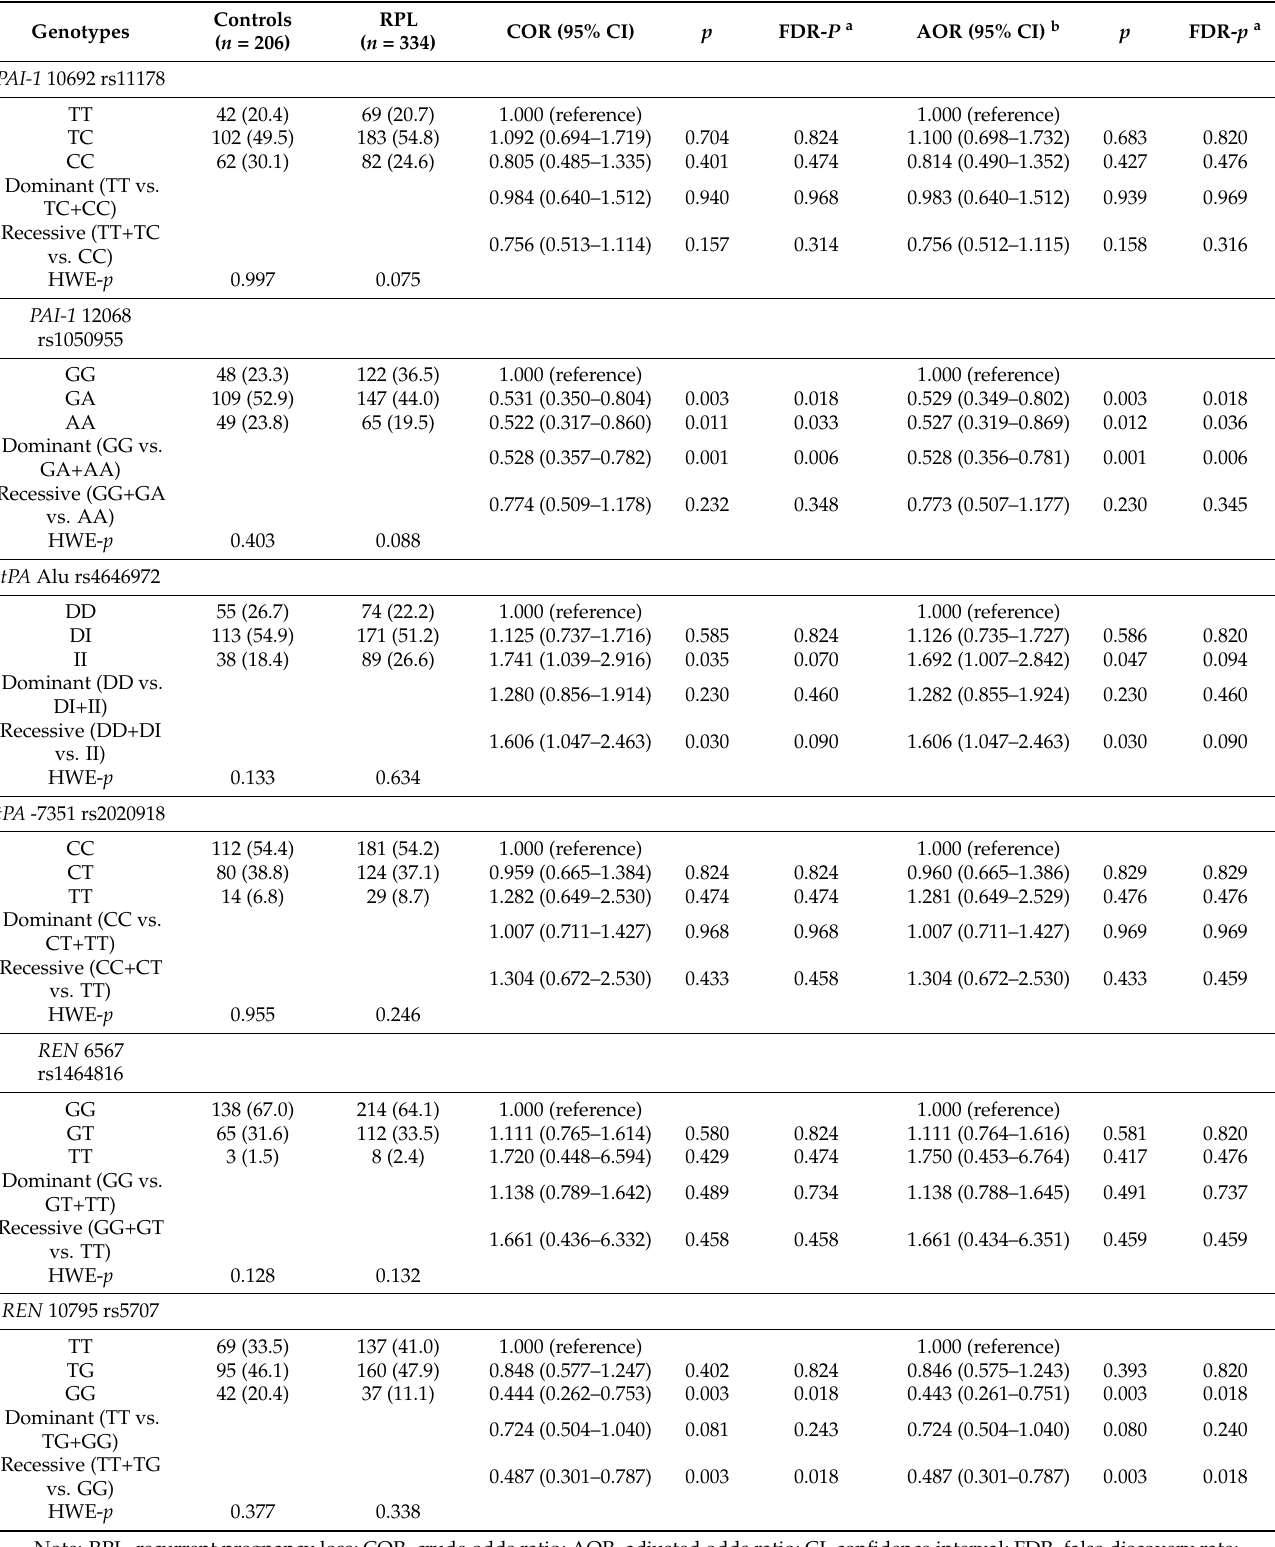
Table 2. Genotype frequencies of PAI-1 , t-PA and REN gene polymorphisms between controls and RPL